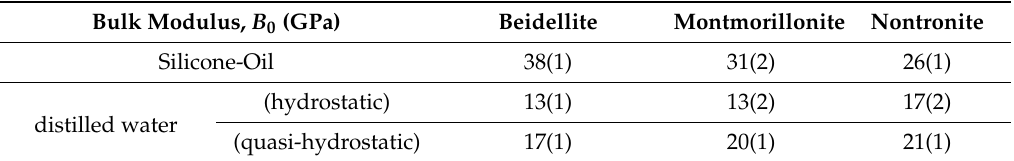
Table 1. Bulk moduli of beidellite, montmorillonite, and nontronite under silicone oil and distilled water PTMs (ESD’s (estimated standard deviations) are in